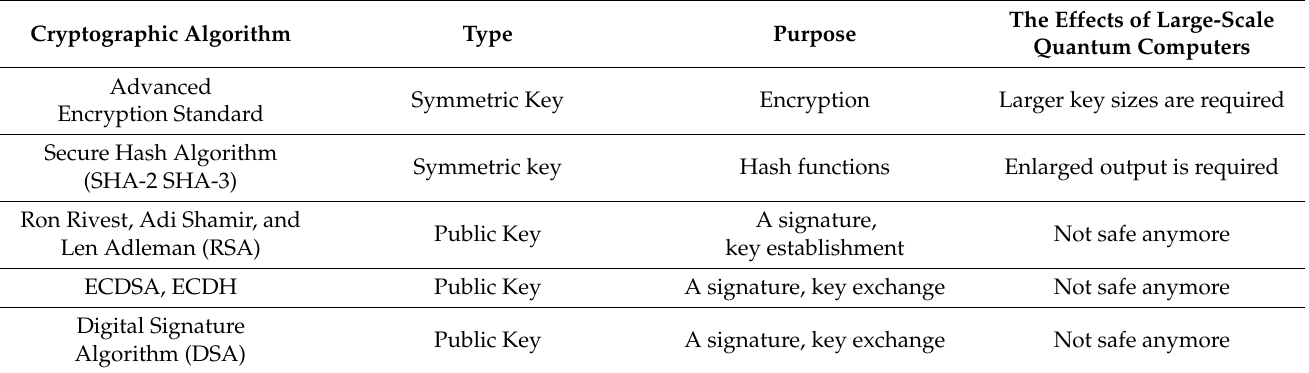
Table 2. The effect of quantum computing on traditional cryptography